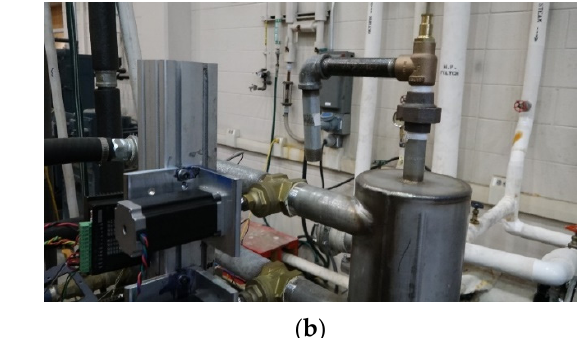
Figure 4. Heat removal rate vs. time for single- and two-radiator configurations.